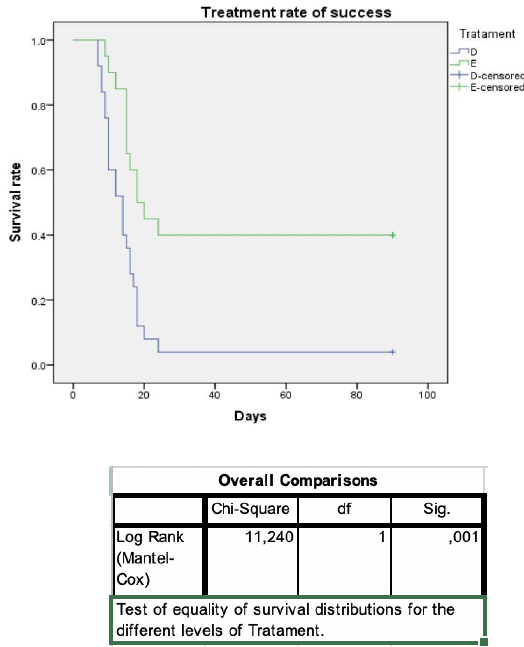
Figure 5. Kaplan–Meier curves showing healing time between patients receiving dental treatment (D) or endoscopic sinus surgery (E). 4% failure rate in D group and 40% in E group. Mean time to healing was 14 days for D, and 18 days for E. 1 Log-Rank test for comparing survival rates shows a statistically significant difference ( p = 0.001) between dental end endoscopic treatment.